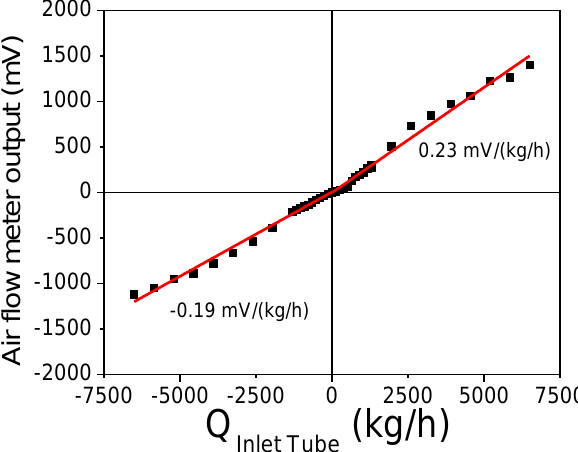
Figure 9. Calibration curve of the air flow meter output as a function of air flow through the engine air inlet tube. Black squares are the experimental data, while the red lines represent the linear fit to these data in the forward and reverse flow